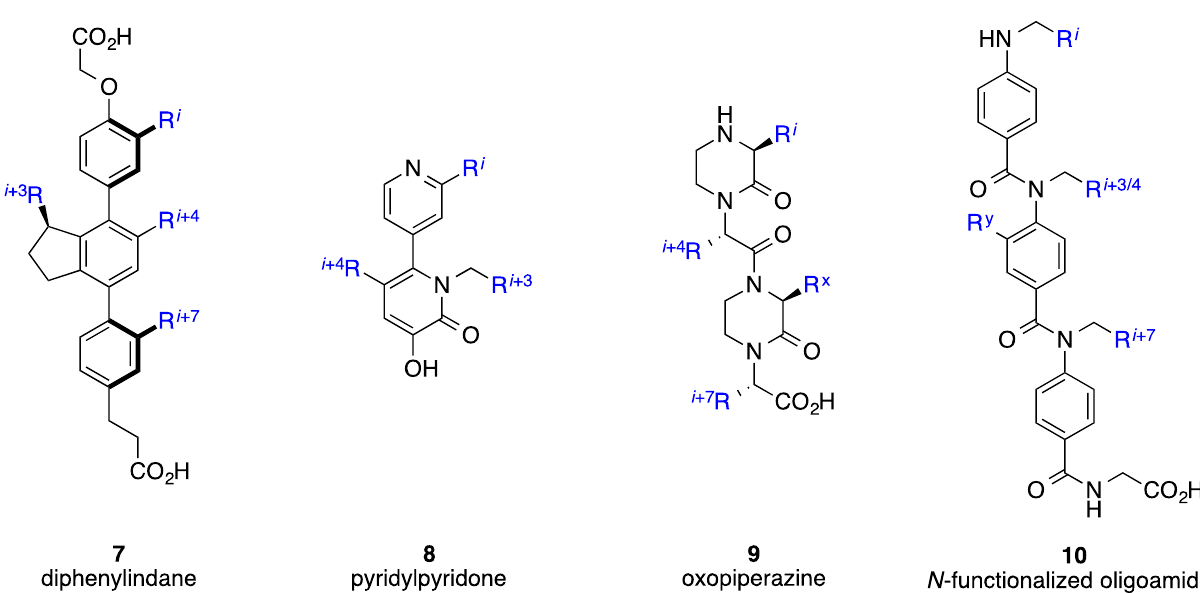
Figure 3. Multi-sided, single-faced, synthetic α-helix mimetics. R x and R y may be solubilizing groups or moieties to improve cell uptake, for